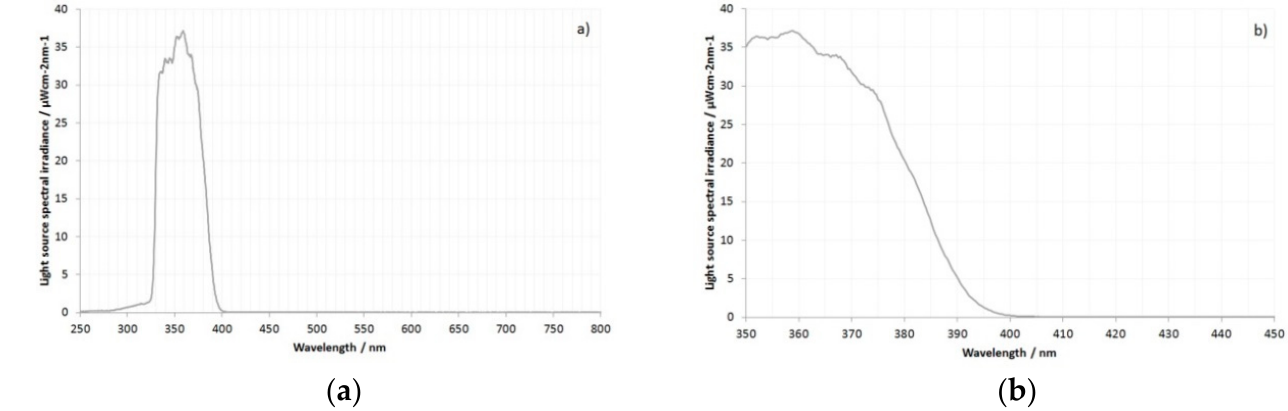
Figure 1. Output of the test light source after filtering with Baader U-Venus filter: ( a ) Full spectral range of 250 nm to 800 nm; ( b ) 350 nm to 450 nm. The test filters exhibited a wide range of fluorescence under UV light, both in terms of the brightness of the fluorescence and its color. The relative degree of fluorescence (normal- ized for the exposure times used during image capture) and its color are given in Table 1, along with the filter thicknesses. The filter fluorescence ranked and normalized in relation to Schott KV-418 is shown in Figure 2 to enable the filters to be more readily compared. Table 1. Test filter degree of fluorescence normalized to ‘per second’, the observed fluorescence color and filter